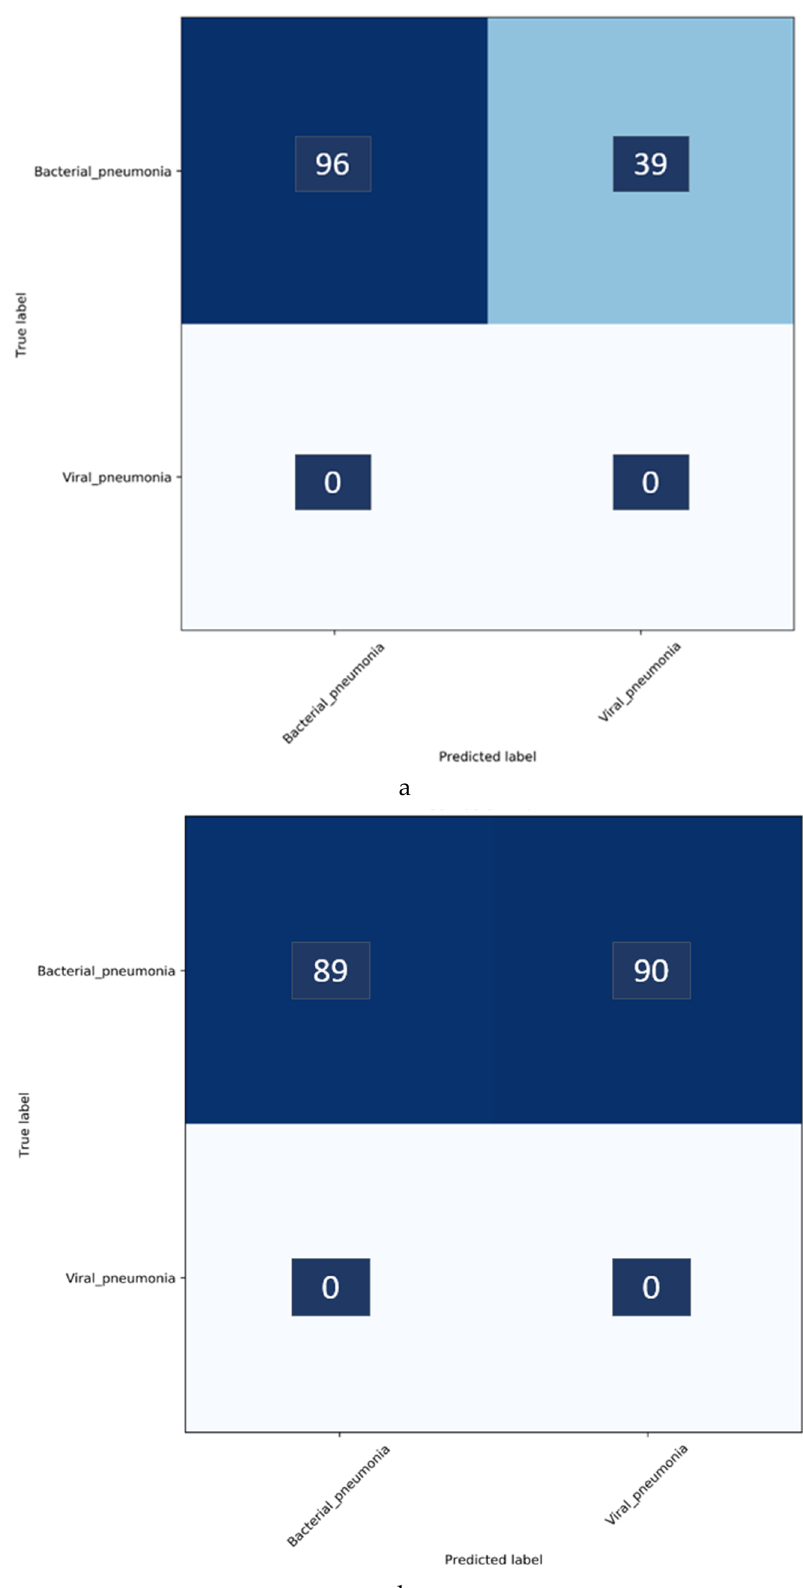
Figure 4. Confusion matrix after classifying bacterial and viral pneumonia in the (a) Twitter-COVID-19 and (b) Montreal-COVID-19 CXR collections. Enlarged text labels have been manually superimposed for clarity.